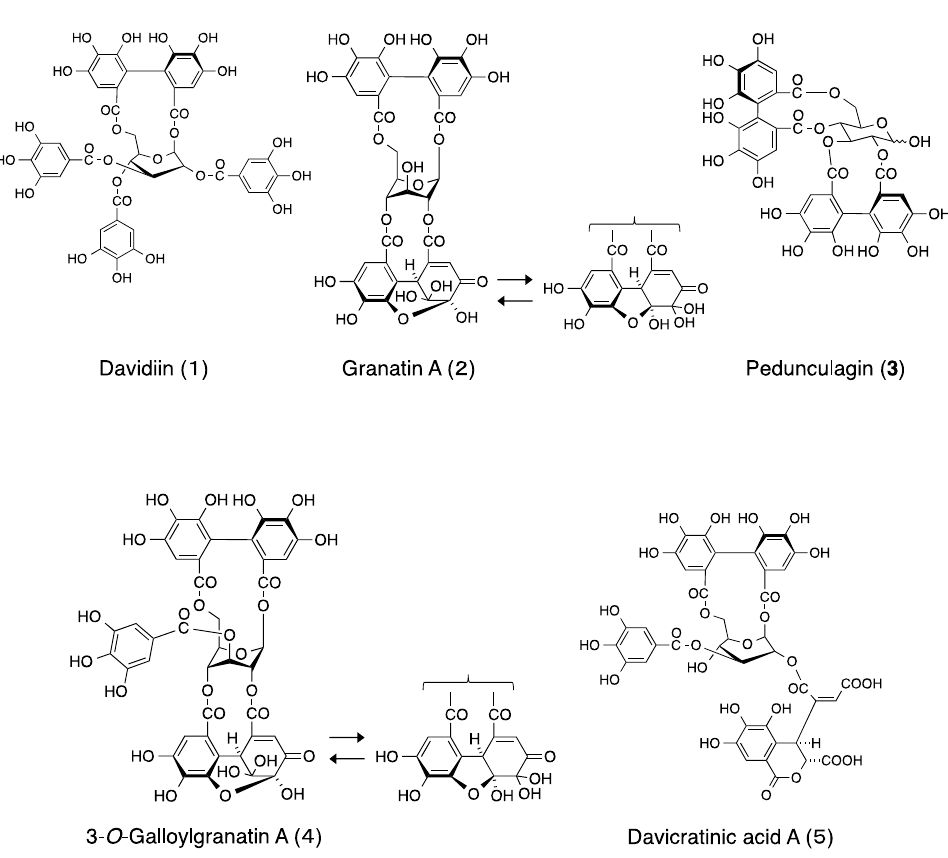
Figure 1. Structures of hydrolysable tannins isolated from Davidia involucrata .